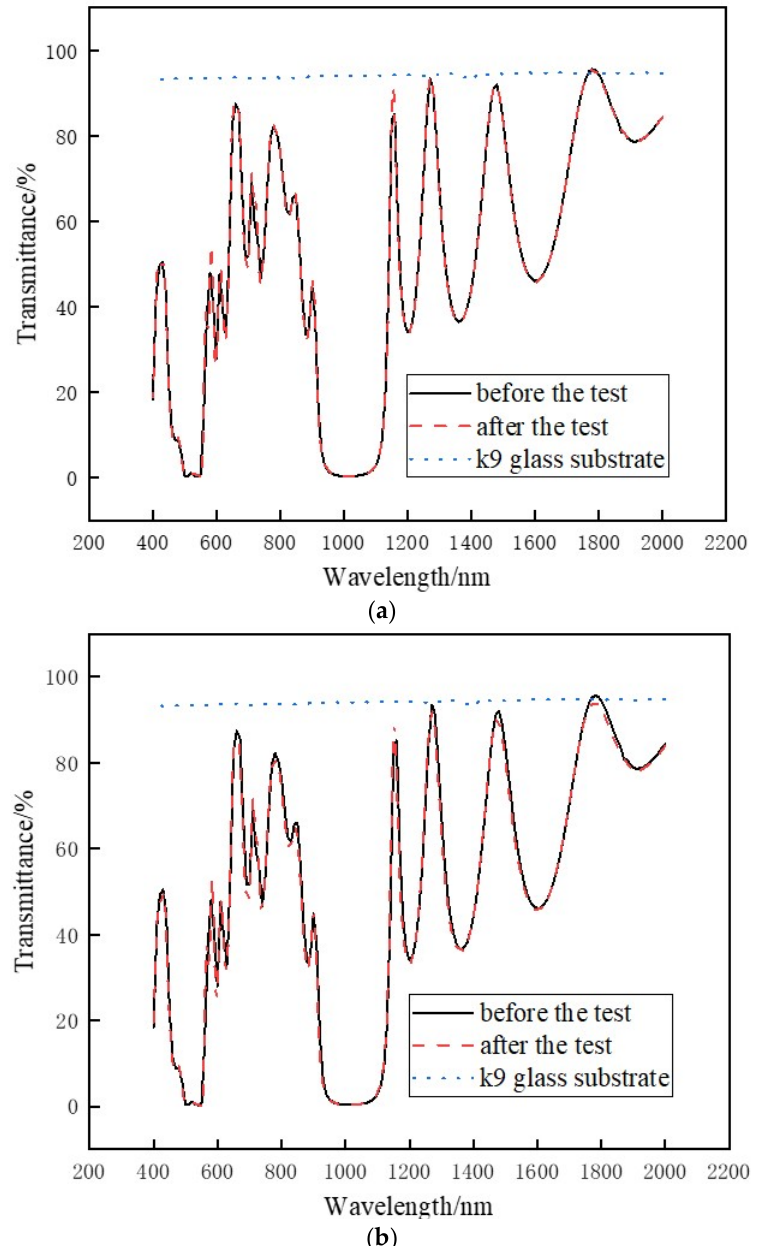
Figure 2. Transmission spectra of the non-regularized highly reflective TiO 2 /SiO 2 film before and after testing at ( a ) 1064 nm and ( b ) 532 nm.